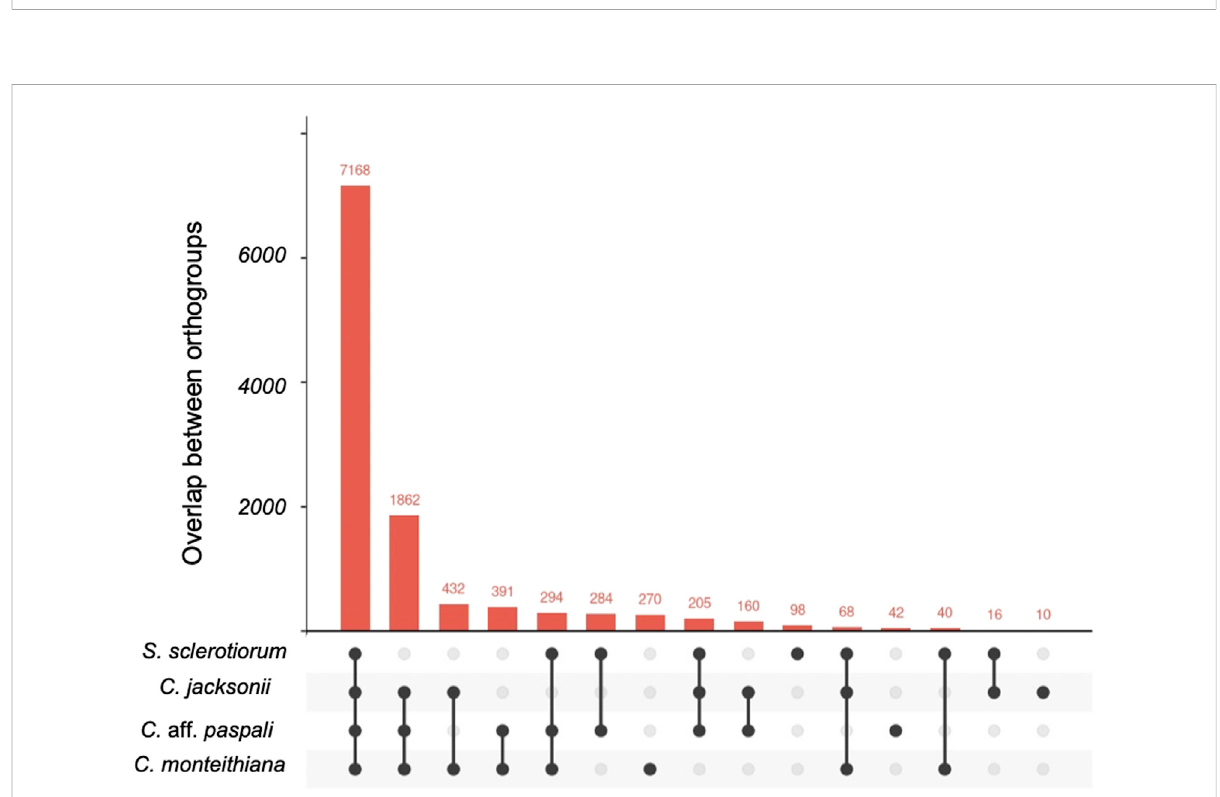
FIGURE 4 Upset plot of orthologous gene clusters between C. aff. paspali and other related species. One to several genes can be present within each orthogene cluster. S.sclerotiorum , C.jacksonii , C.monteithiana ,and C .aff. paspali are representedbythegenomeofisolates1980 UF-70, LWC-10, DRR09, and H3,